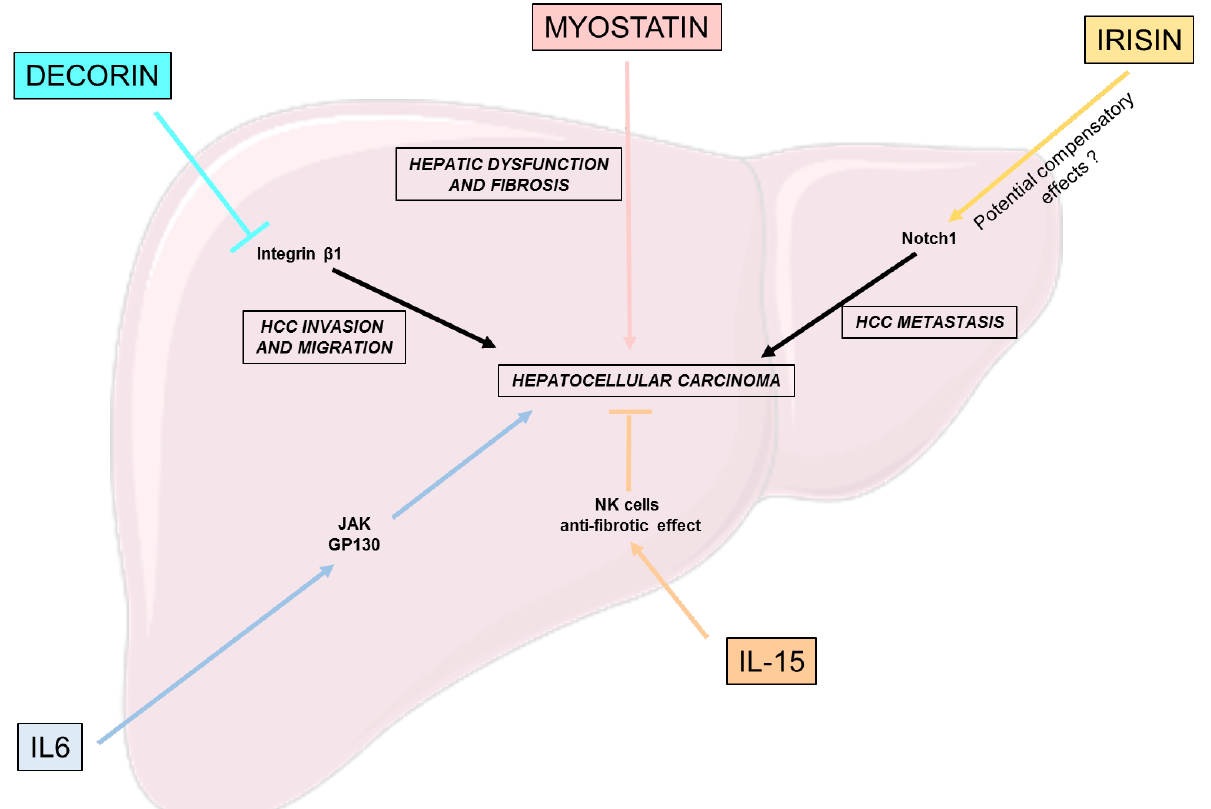
Figure 4. Effects of myokines on hepatocellular carcinoma. This figure puts a light on the beneficial and deleterious effects of different myokines on the different pathways involved in the development of hepatocellular carcinoma: hepatic dysfunction, fibrosis, HCC cell invasion, migration and metastasis. gp130: Glycoprotein 130; HCC: Hepatocellular carcinoma; IL-6: Interleukine 6; IL-15: Interleukine 15; NK: Natural killer.